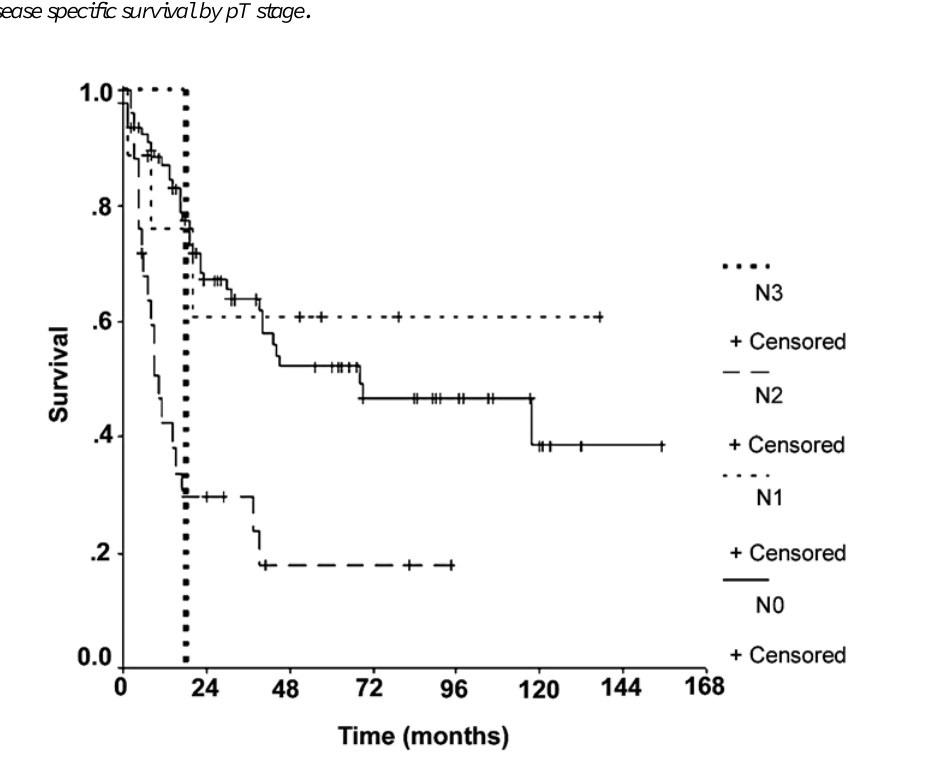
Figure 3 – Disease specific survival by N